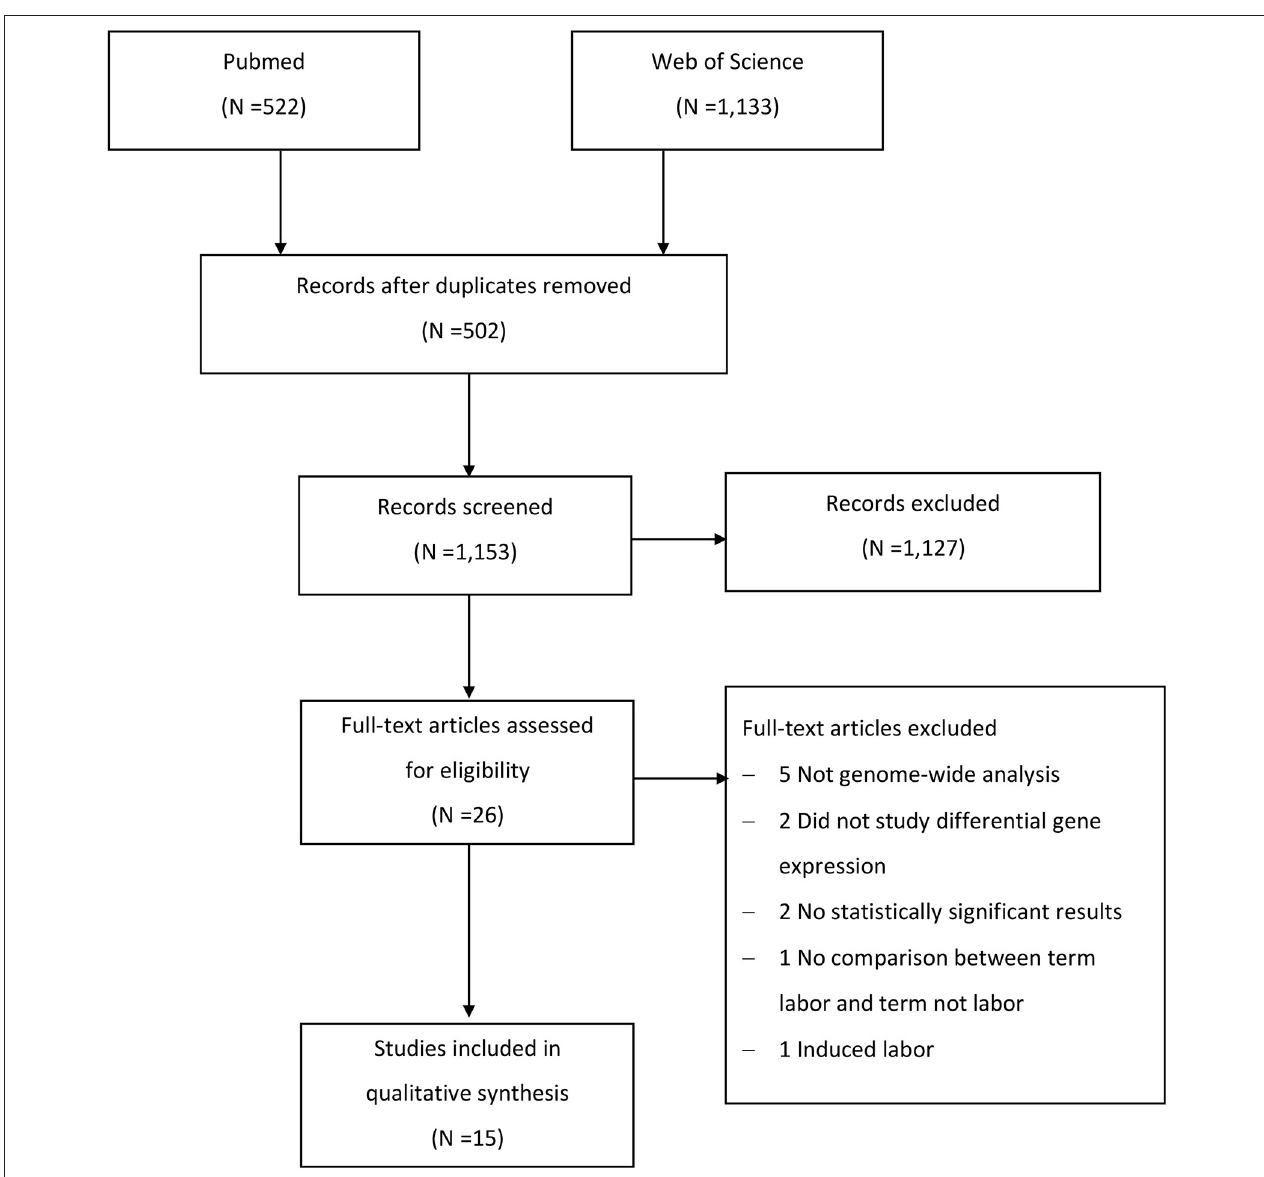
FIGURE 1 | Flow chart of study selection.